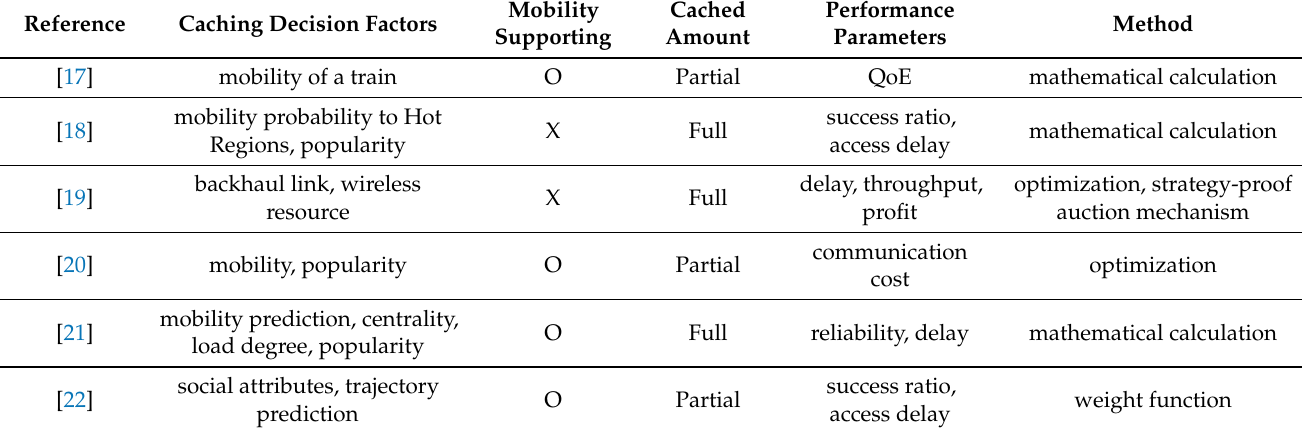
Table 1. The summary of the related works on precaching in